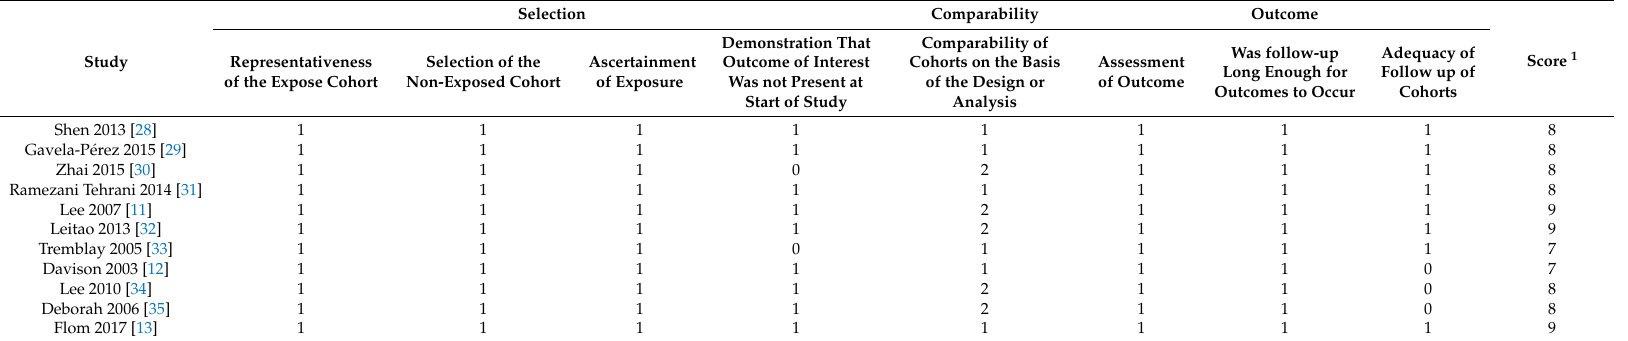
Table 3. The Newcastle-Ottawa Scale (NOS) for assessing the methodology quality of cohort